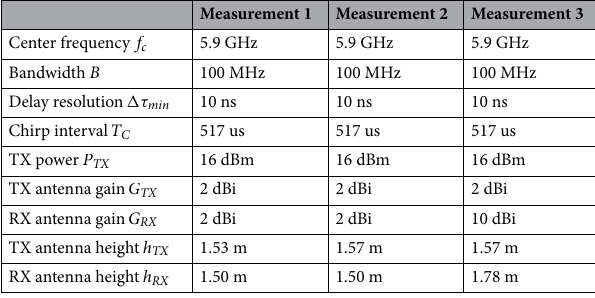
Table 1. Measurement